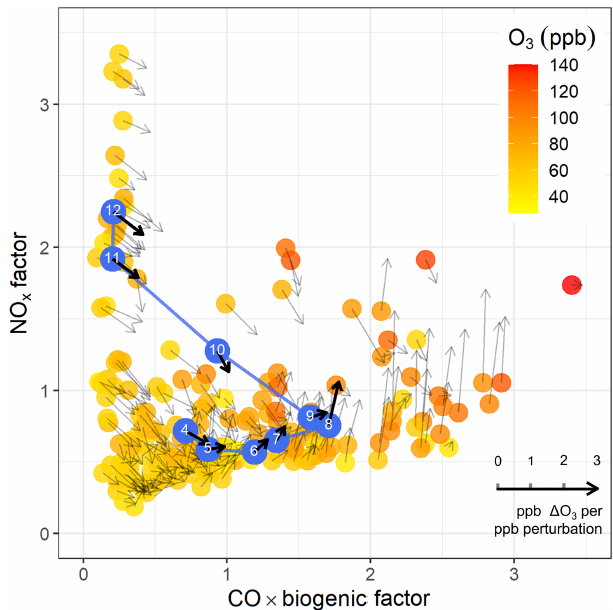
Figure 5. Measured O 3 isopleth diagram. The NO x and CO × biogenic factor is calculated by the daily value divided by av- eraged value. The O 3 concentration is the daily O 3 concentration in the base case chamber after 3h UV exposure. Arrows represent the O 3 sensitivity. The blue dots are the monthly-averaged values, and the blue line shows the seasonal cycle in the O 3 isopleth diagram. Days influenced by wildfires are removed from the plot.